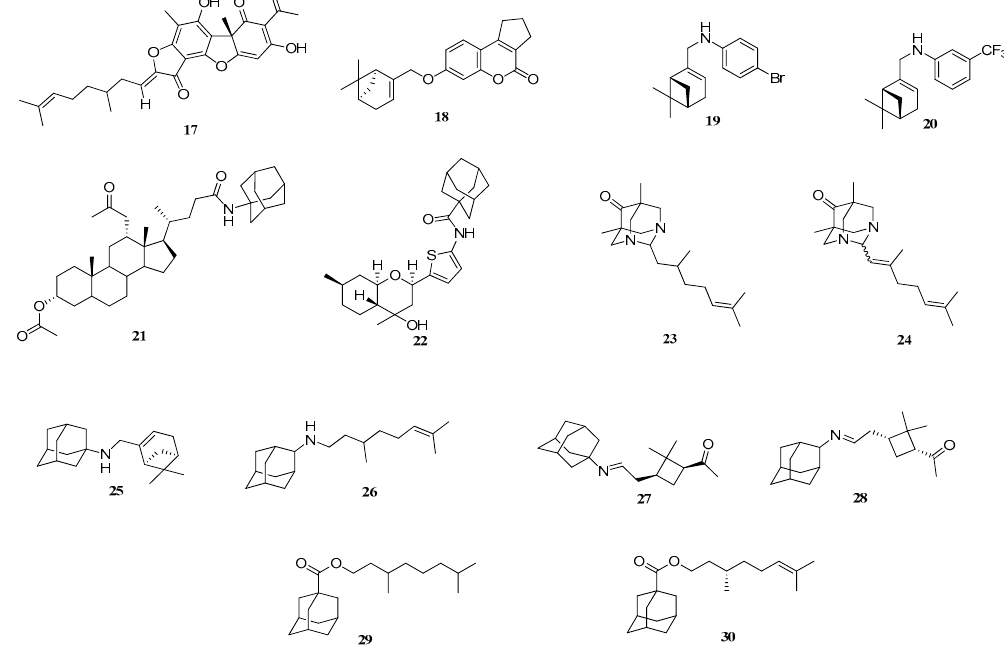
Figure 2. Monoterpenes and adamantane / diazaadmanatane derivatives with Tdp1 inhibitory activity. Figure 2. Monoterpenes and adamantane/diazaadmanatane derivatives with Tdp1 inhibitory activity. Previously we synthesized a number of esters of 1-adamantane carboxylic acid containing Figure 2. Monoterpenes and adamantane/diazaadmanatane derivatives with Tdp1 inhibitory fragments of acyclic, monocyclic and bicyclic monoterpenoids. A potent Tdp1 inhibitory activity.